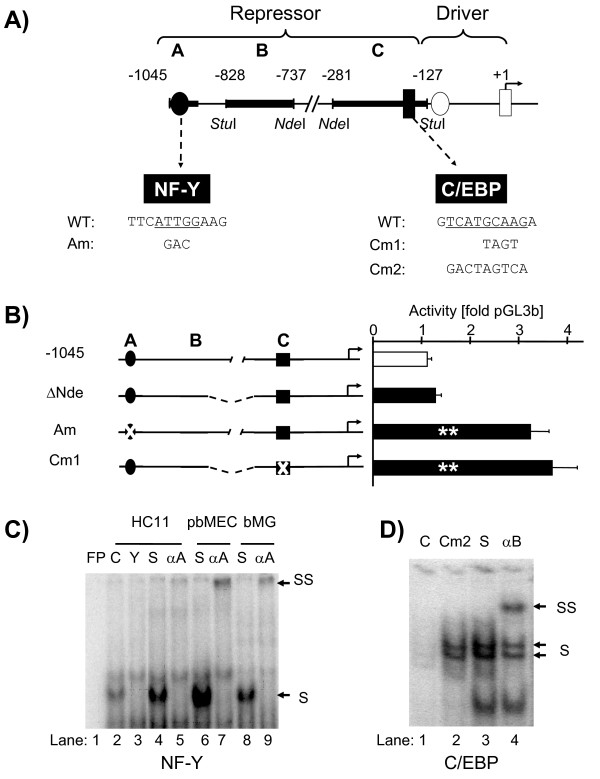
NF-Y and C/EBP binding sites in element A and C respectively in the distal region are involved in PIA repression. (A) Genomic organization of PIA. The distal region includes three putative repressive elements, as revealed by coarse mapping analyses involving StuI and NdeI deletions, respectively (filled boxes, element A, B, C). Element A harbors a NF-Y attachment site (filled circle), and element C contains a C/EBP binding site (filled square). The core binding sequences of those factors and mutational derivatives are shown. The proximal driving region features a NF-Y site (open circle) and a C/EBP binding site (open square). ‘+1’ represents the tsp. (B) Abrogation of NF-Y binding and C/EBP binding in the distal PIA relieves repression in reporter gene assay. Shown are mean values (+ S.E.M.) of at least three independent experiments, each assayed in triplicate. Significance of difference relative to construct −1045 (WT) is indicated (** P < 0.01). (C) EMSA analysis of transcription factors binding to element A. The labeled probe A_WT (Additional file 1: Table S4) is bound by NF-Y factors from nuclear extracts of HC-11, pbMEC and bMG (“S”) and is supershifted (SS) by the addition of antibodies against NF-YA (αA). Lanes: FP, free probe; C and Y, competition with 100-fold molar excess of the unlabeled A_WT probe and a probe harboring an NF-Y consensus site respectively (Additional file 1: Table S4). (D) EMSA validation that C/EBP factors bind to element C. Nuclear extracts from HC-11 cells were incubated with the radioactively labeled probe C_WT (Additional file 1: Table S4). Lane: C, competition with 100-fold molar excess of unlabeled C_WT; S, shift; αB, supershift (“SS”) with anti-C/EBP antibodies; Cm2, competition with 100-fold molar excess of the unlabeled probe mutated as shown in Figure 2A.